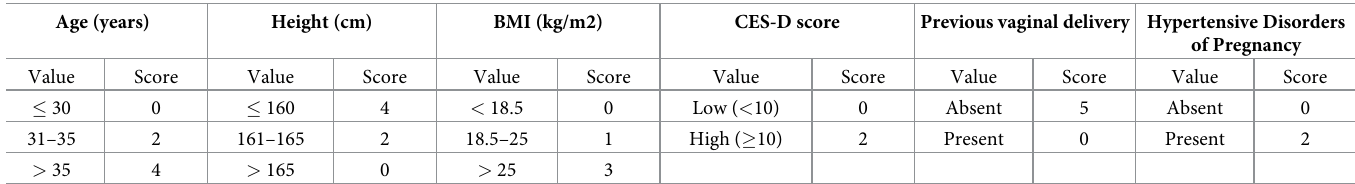
Table 3. Modified antenatal scoring system for predicting the risk of Emergency